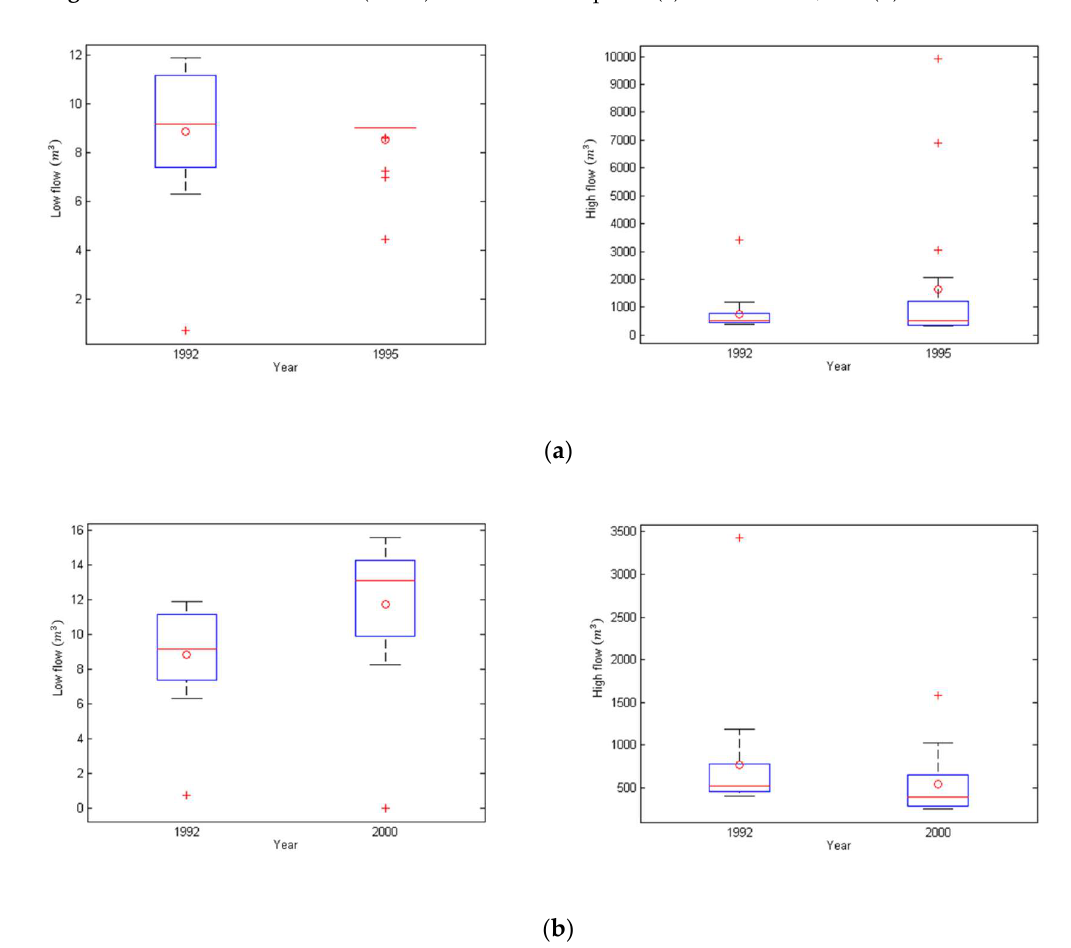
Figure 10. Comparison on the magnitude of low flows and high flows in selected pairs: ( a ) 1992 vs. 1995; and ( b ) 1992 vs. 2000. Table 7. Statistical tests for the effect of forest disturbances on the low flows and high